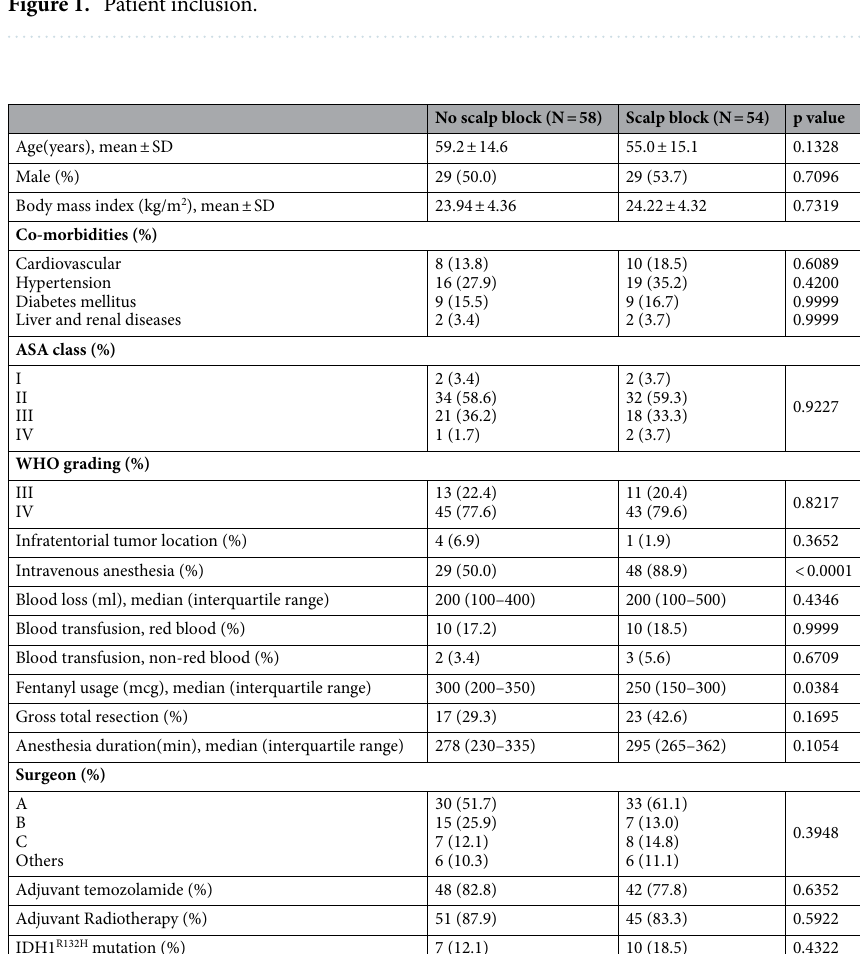
Figure 1. Patient inclusion.